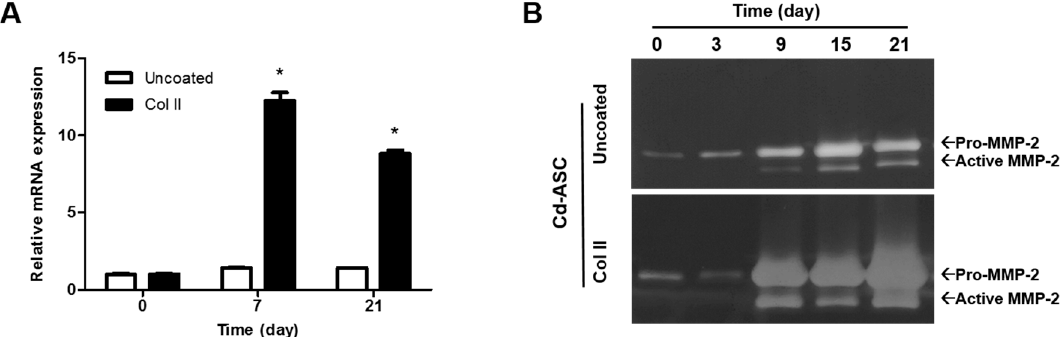
Figure 4. Cont. Figure 4. Cont.